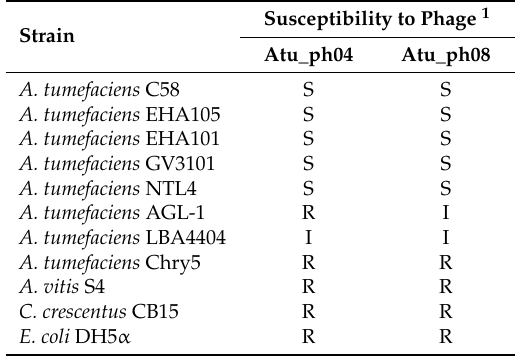
Table 2. Host range testing of Atu_ph04 and Atu_ph08.